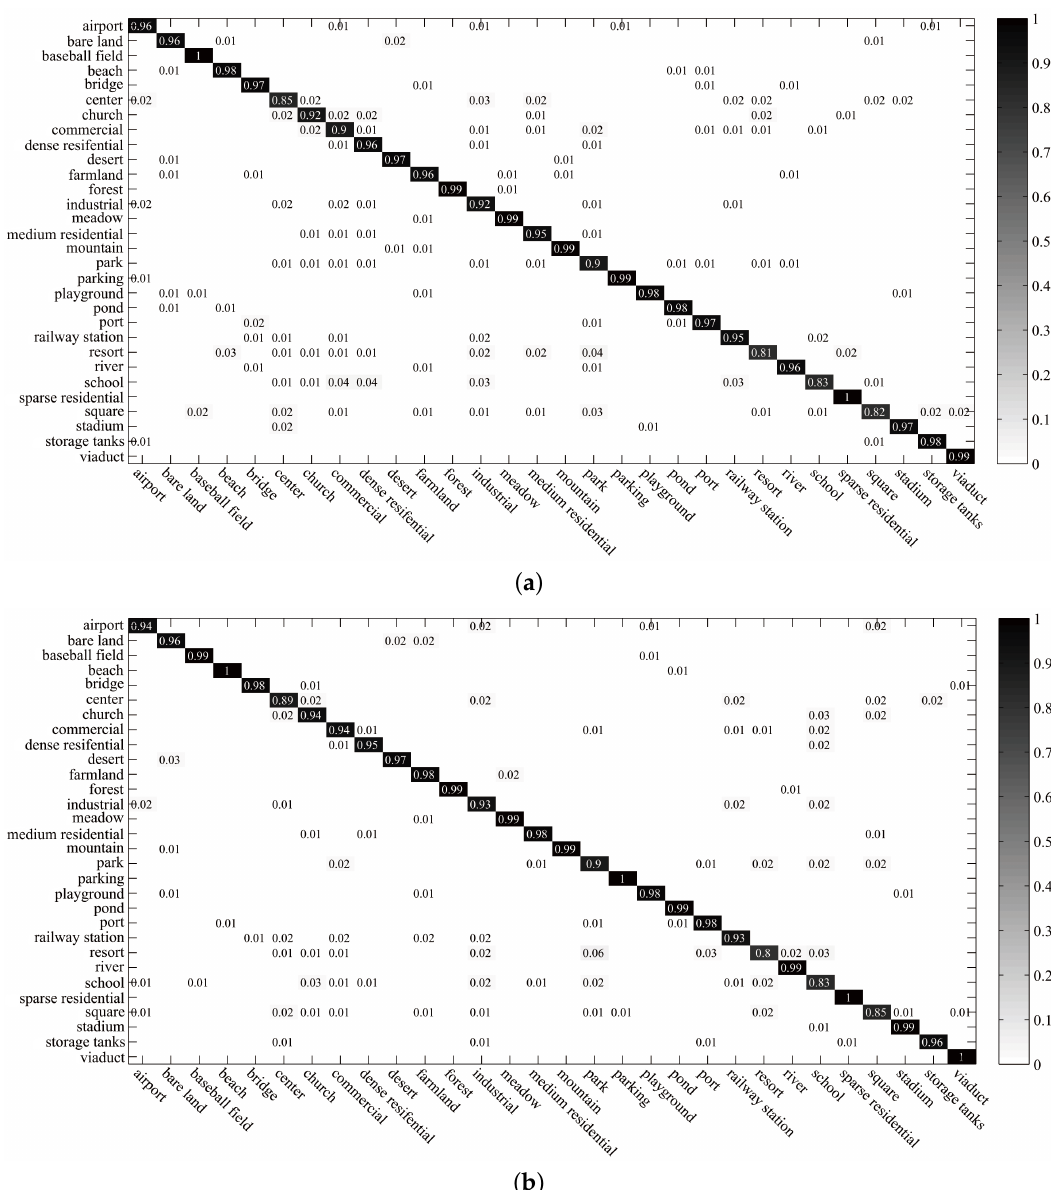
Figure 12. Confusion matrixes of the AID dataset under the training ratio of 50% using the following methods. ( a ) texture coded two-stream architecture with our proposed fusion model; ( b ) saliency coded two-stream architecture with our proposed fusion